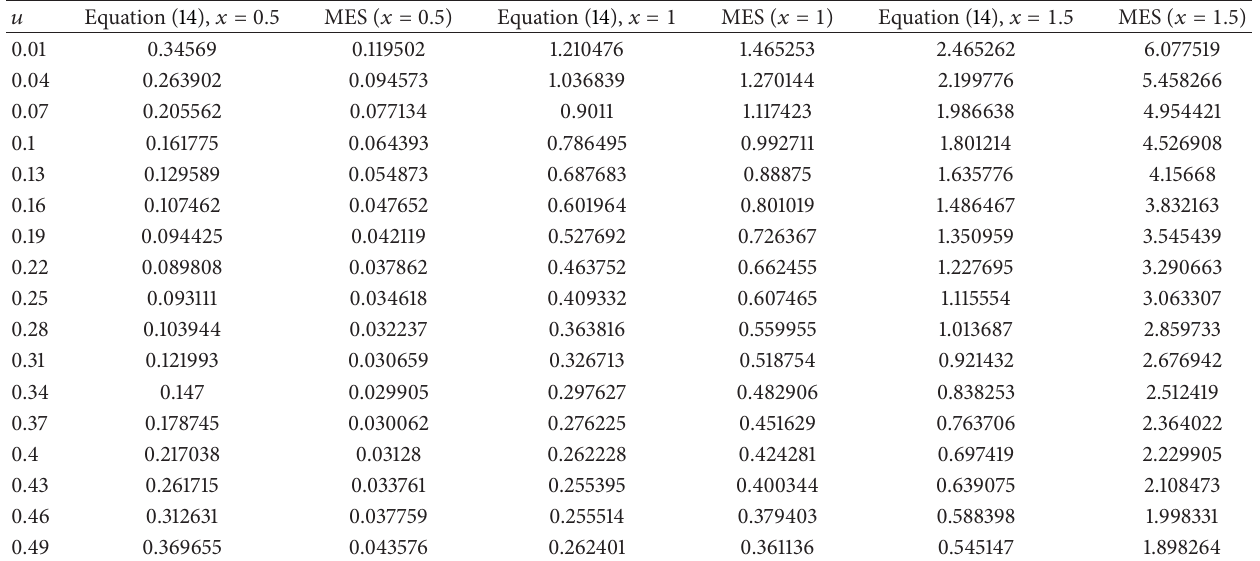
Table 4: Equation (14): 𝐷 1/5 𝑥 2 = 3.6 ∗ 𝑢 4/5 ∗ (𝑥 − 𝑢)